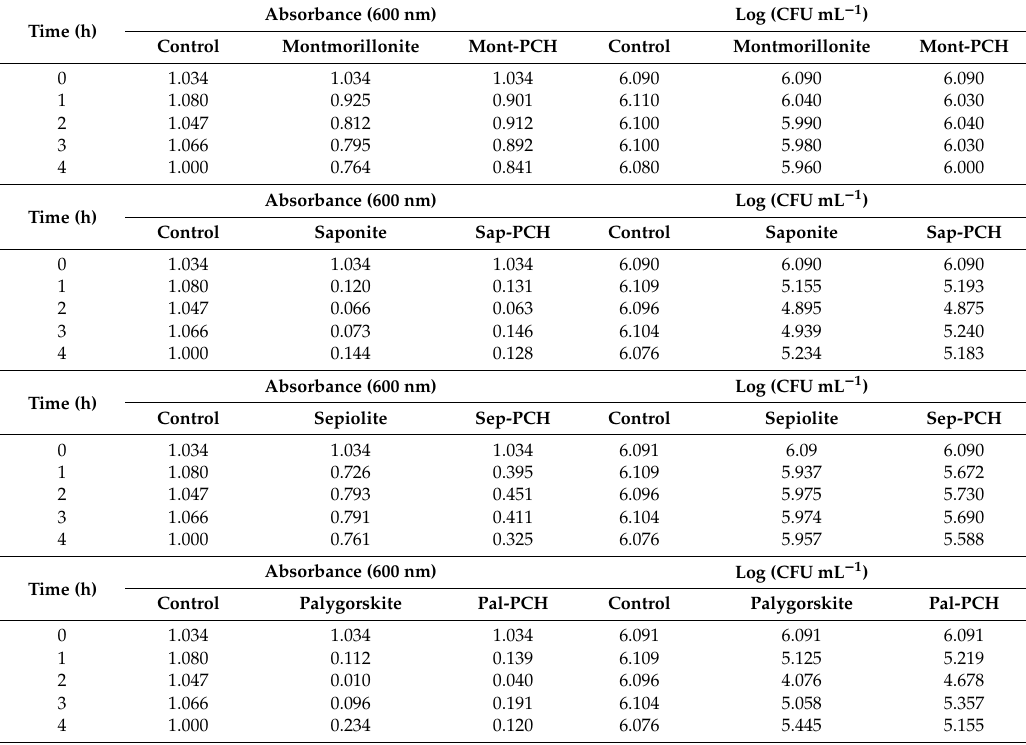
Table 2. Values of absorbance and corresponding Salmonella concentration (CFU mL − 1 ) after the addition of the di ff erent clay minerals and